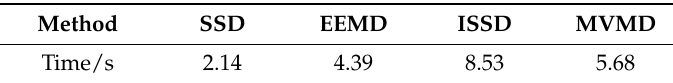
Table 3. Run time of each method. MVMD:.